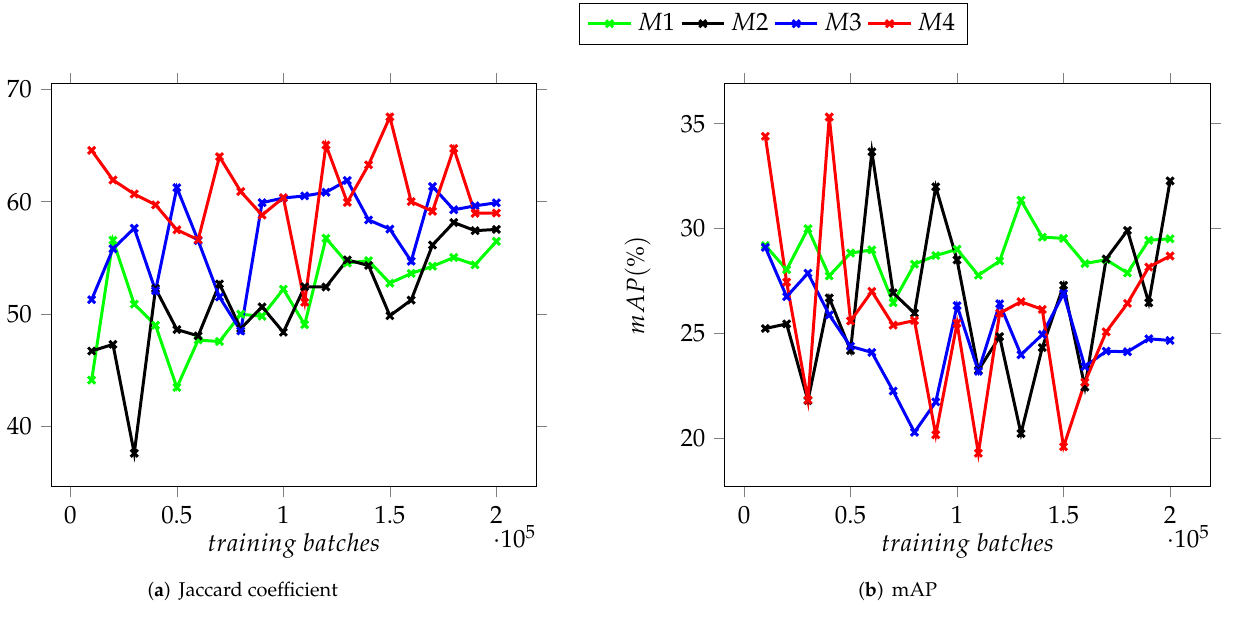
Figure 10. Average Jaccard coefficient and mAP for the trained detection models on validation Dataset